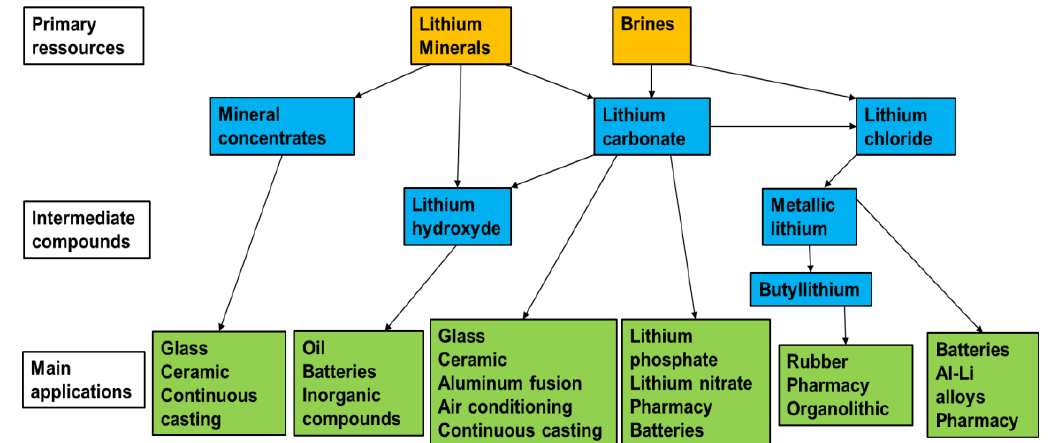
Figure 1. Diagram of lithium usages [16] (adapted with permission from Elsevier, Resources Policy; published by Elsevier, 2019).